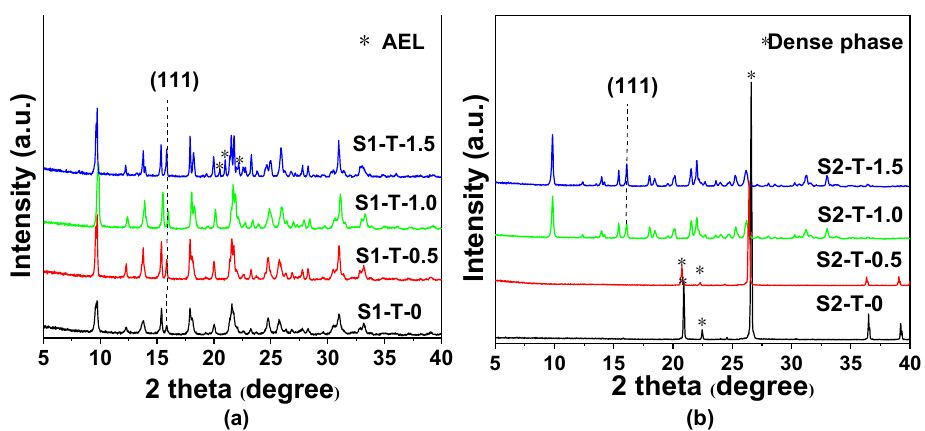
Figure 8. XRD patterns of samples under different molar amounts of TEA: ( a ) [EMIm]Cl and ( b ) [BMIm]Cl.